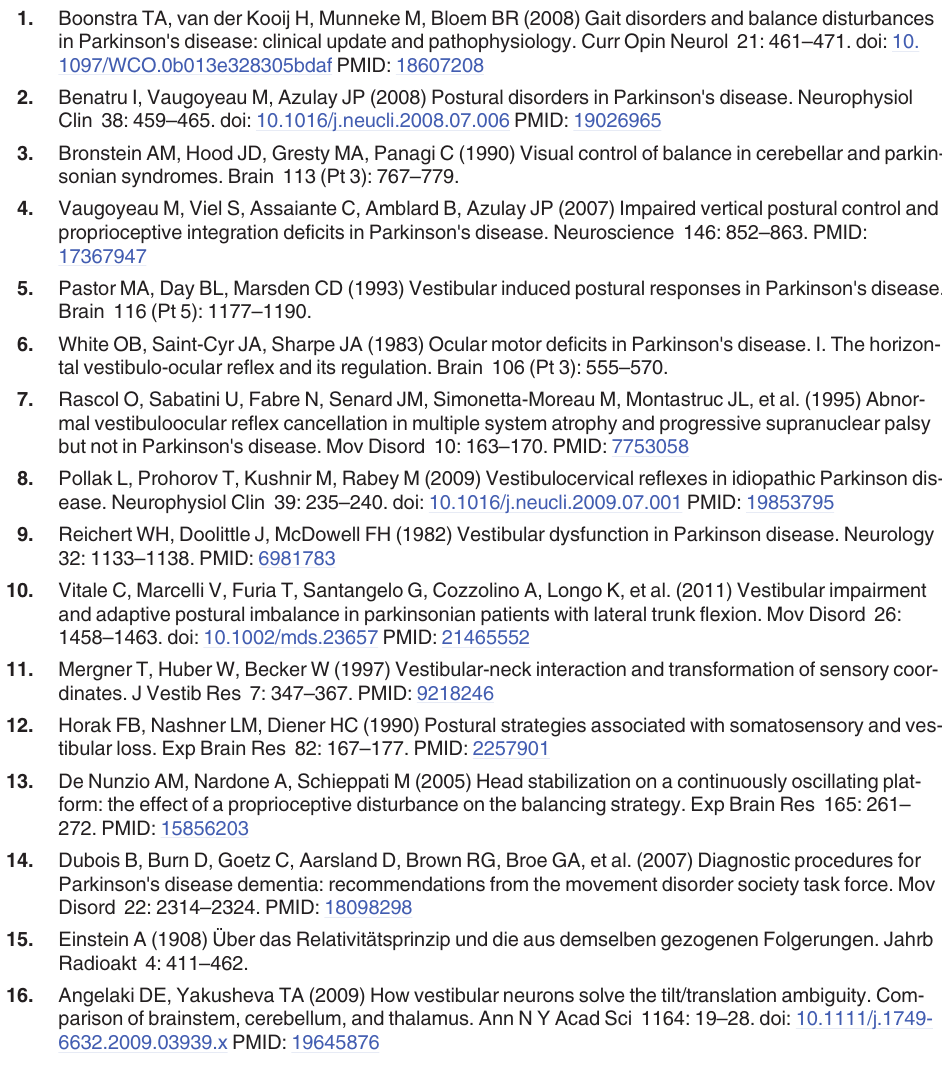
S2 Table. Healthy subjects ’ and Patients ’ responses. The table list the percentage of time the comparison stimulus was judged as larger tilt than the reference stimulus in all the conditions tested by each single patient and single